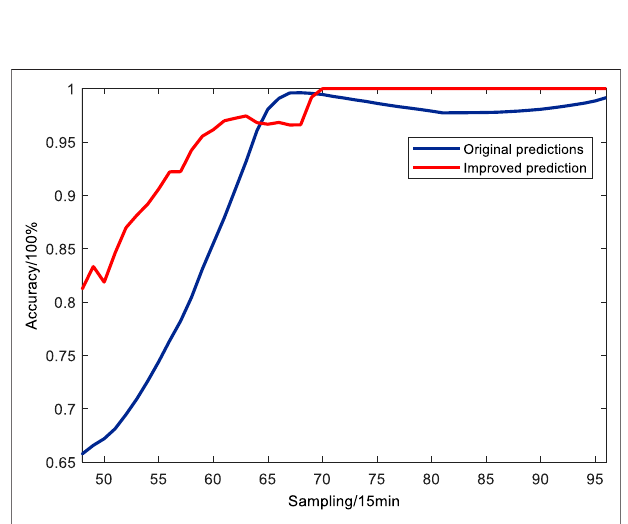
FIGURE13| Predictionaccuracyofeach stepafter improved prediction in the afternoon phase.